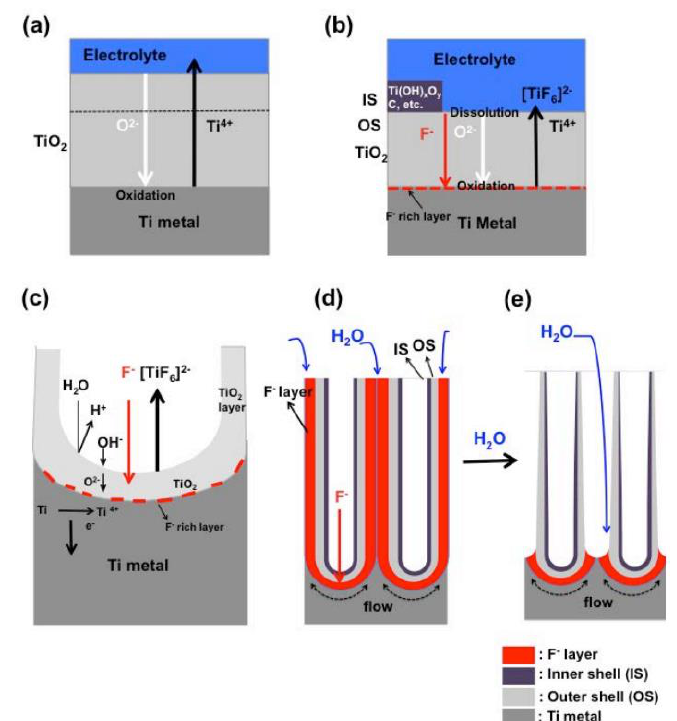
Figure 1. Schematic of the reaction mechanism of TiO 2 anodization. ( a ) O 2 − and Ti 4+ are transported through the oxide layers due to the electric field. ( b ) In presence of fluoride ions, [TiF 6 ] 2 − and an F − -rich layer are generated. The initial formation of a tubular structure is shown in ( c ), and in ( d ) and ( e ) the F − -rich layer is finally dissolved by the water in the electrolyte. Reproduced with permission from ref [11]. Friedrich-Alexander-Universität Erlangen-Nürnberg (2013).